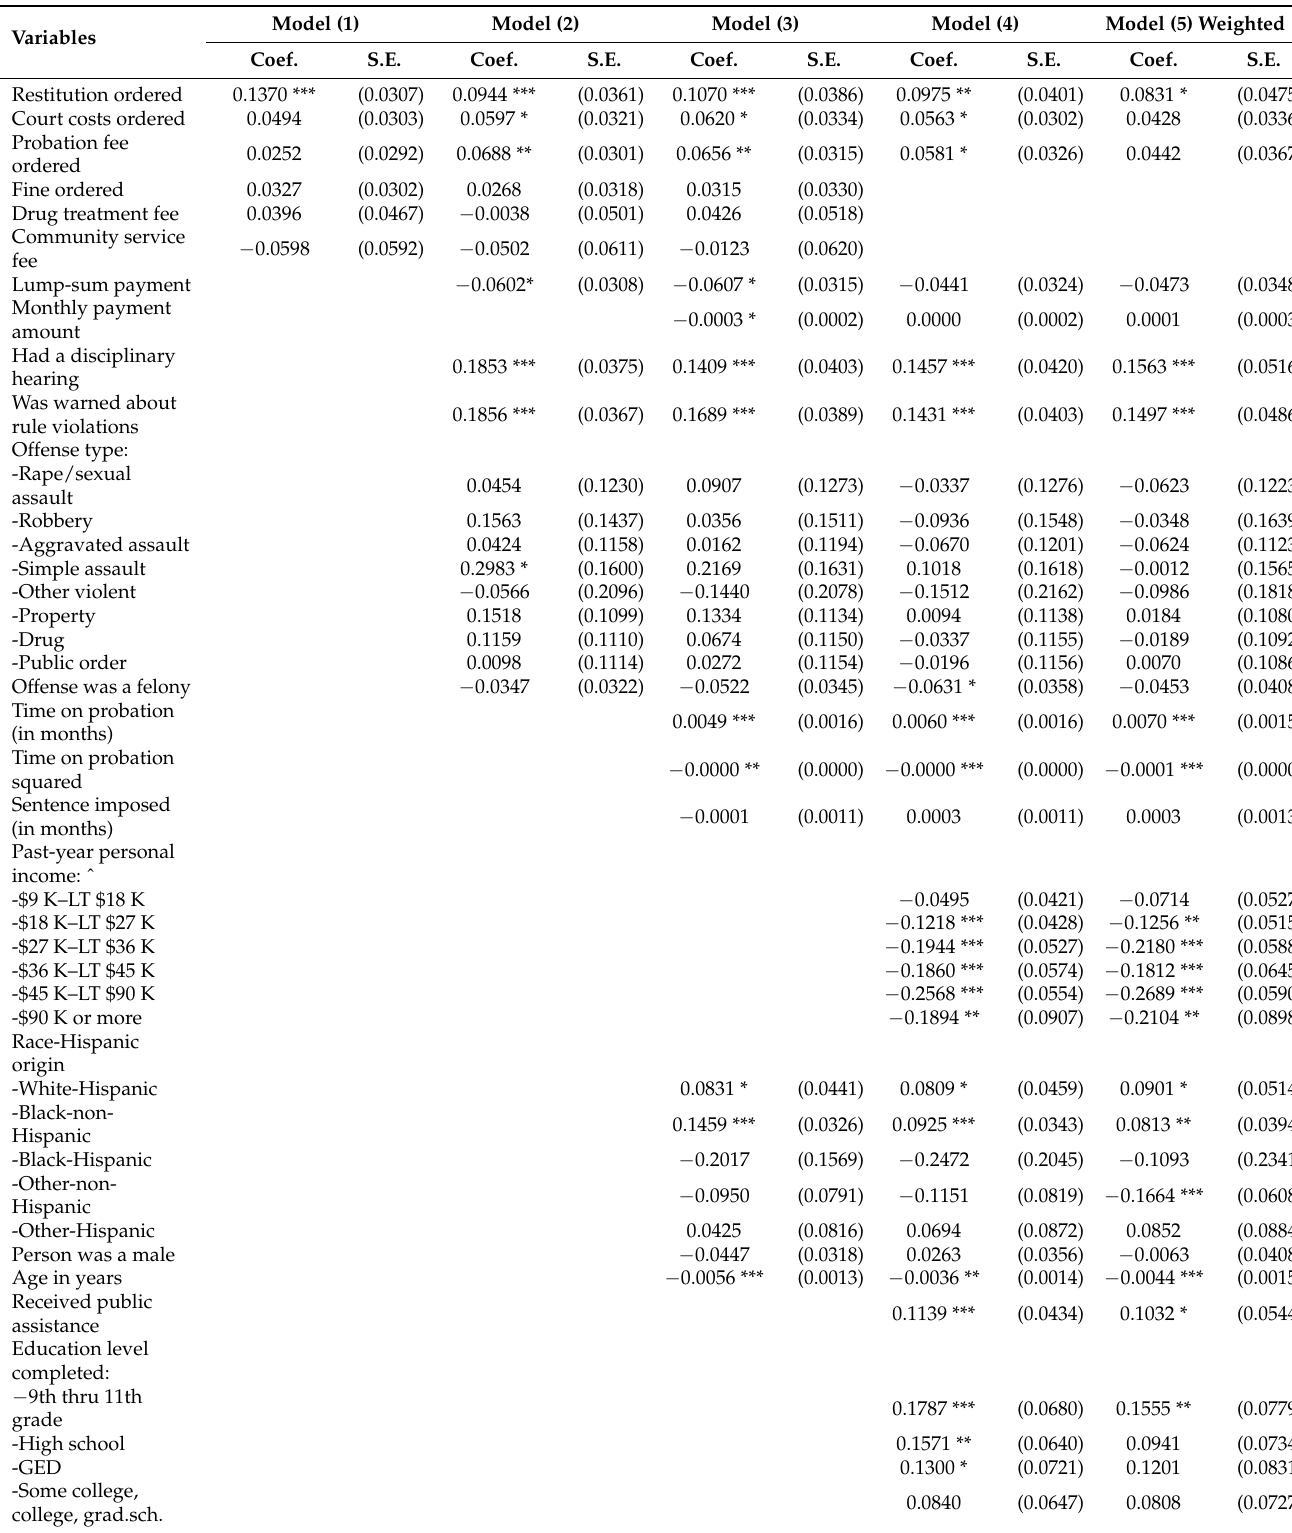
with Table 4, we focus on Model (4) results, our final model, given that it and the weighted estimates in Model (5) are comparable and do not indicate specification error. Table 5. Linear probability model (LPM) estimates of the probability of missing a payment as a function of the specific types of fees/fines